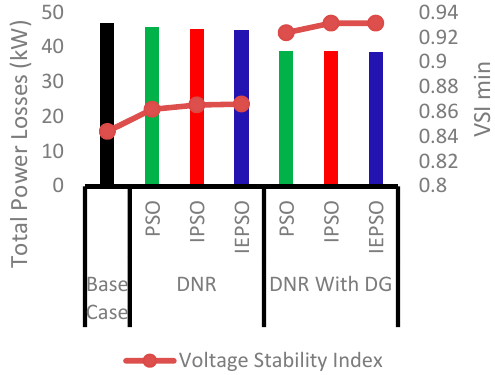
Figure 7. Total power losses and VSI min for DNR without and with DG at light load in 33-bus test system.